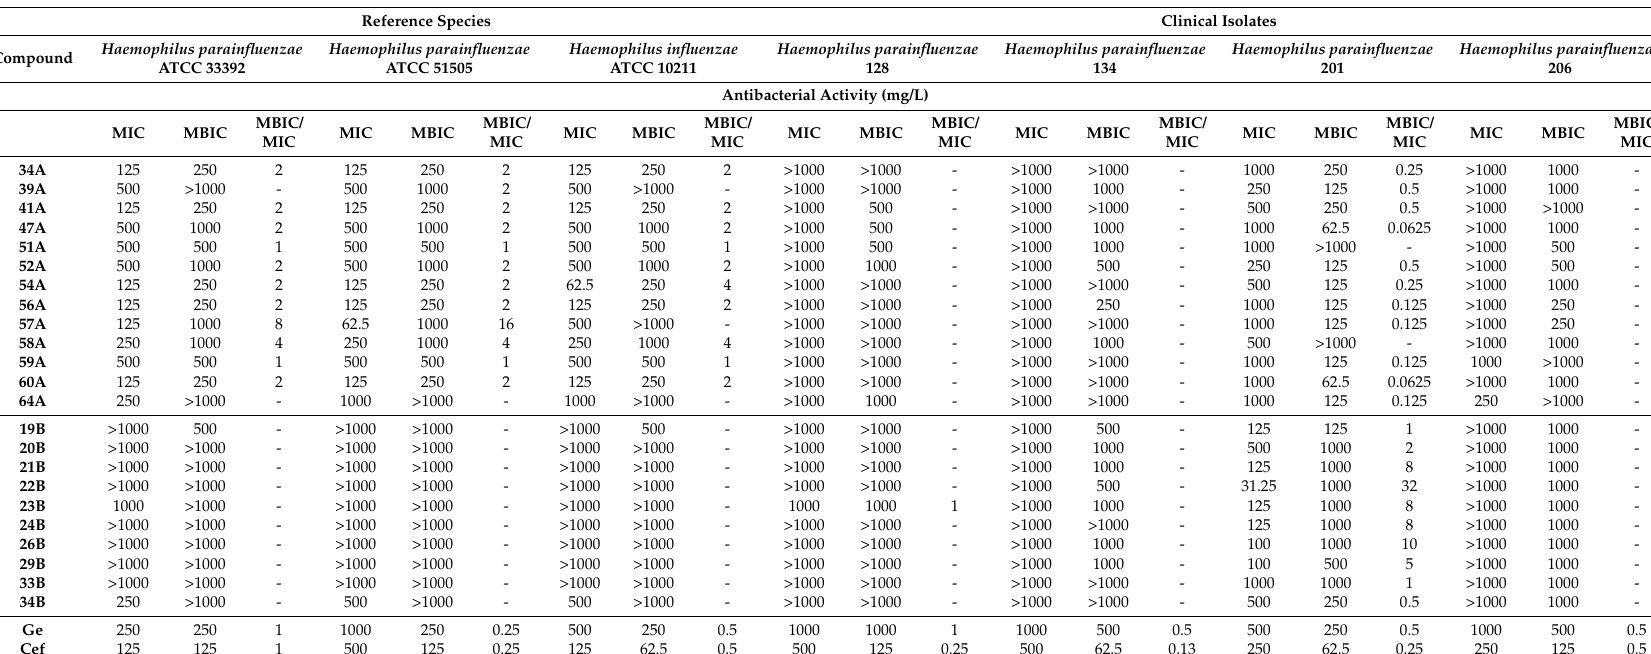
Table 3. The antibacterial activity of TZD-based azolidine and chlorophenyl thiosemicarbazone hybrids against planktonic and biofilm-forming cells, of reference strains and clinical isolates of Haemophilus spp., in vitro under stationary conditions. Reference